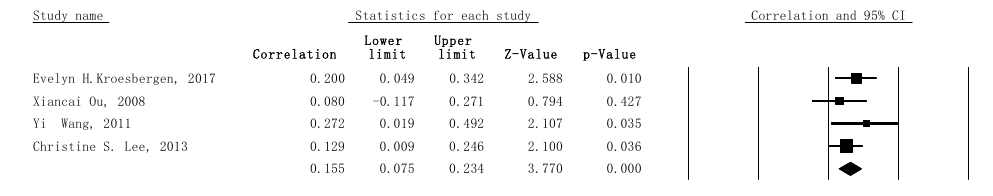
Figure 3. Forest plot with 95% confidence intervals and weights for subgroup meta ‐ analysis, con ‐ cerning the association between verbal WMC tasks and creativity. Larger positive effect sizes indi ‐ cate that increased creativity ability is related to verbal WMC.